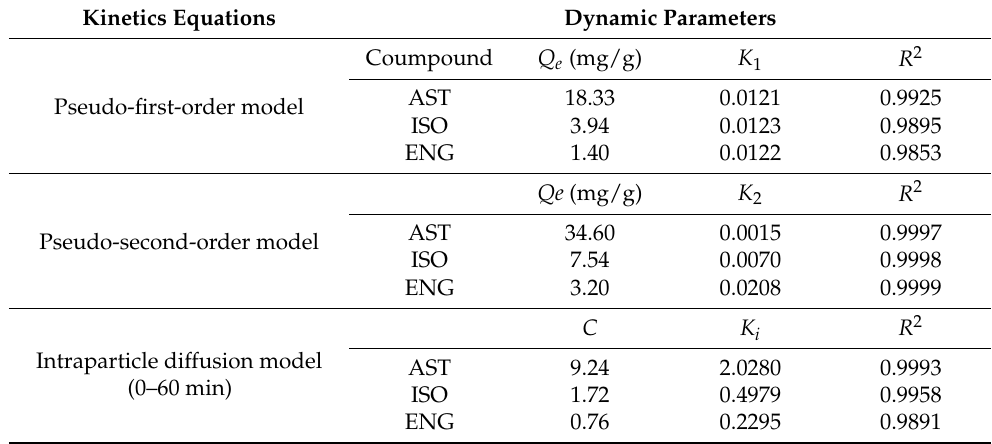
Table 1. Adsorption kinetics parameters for AST, ISO, and ENG on the HPD-300